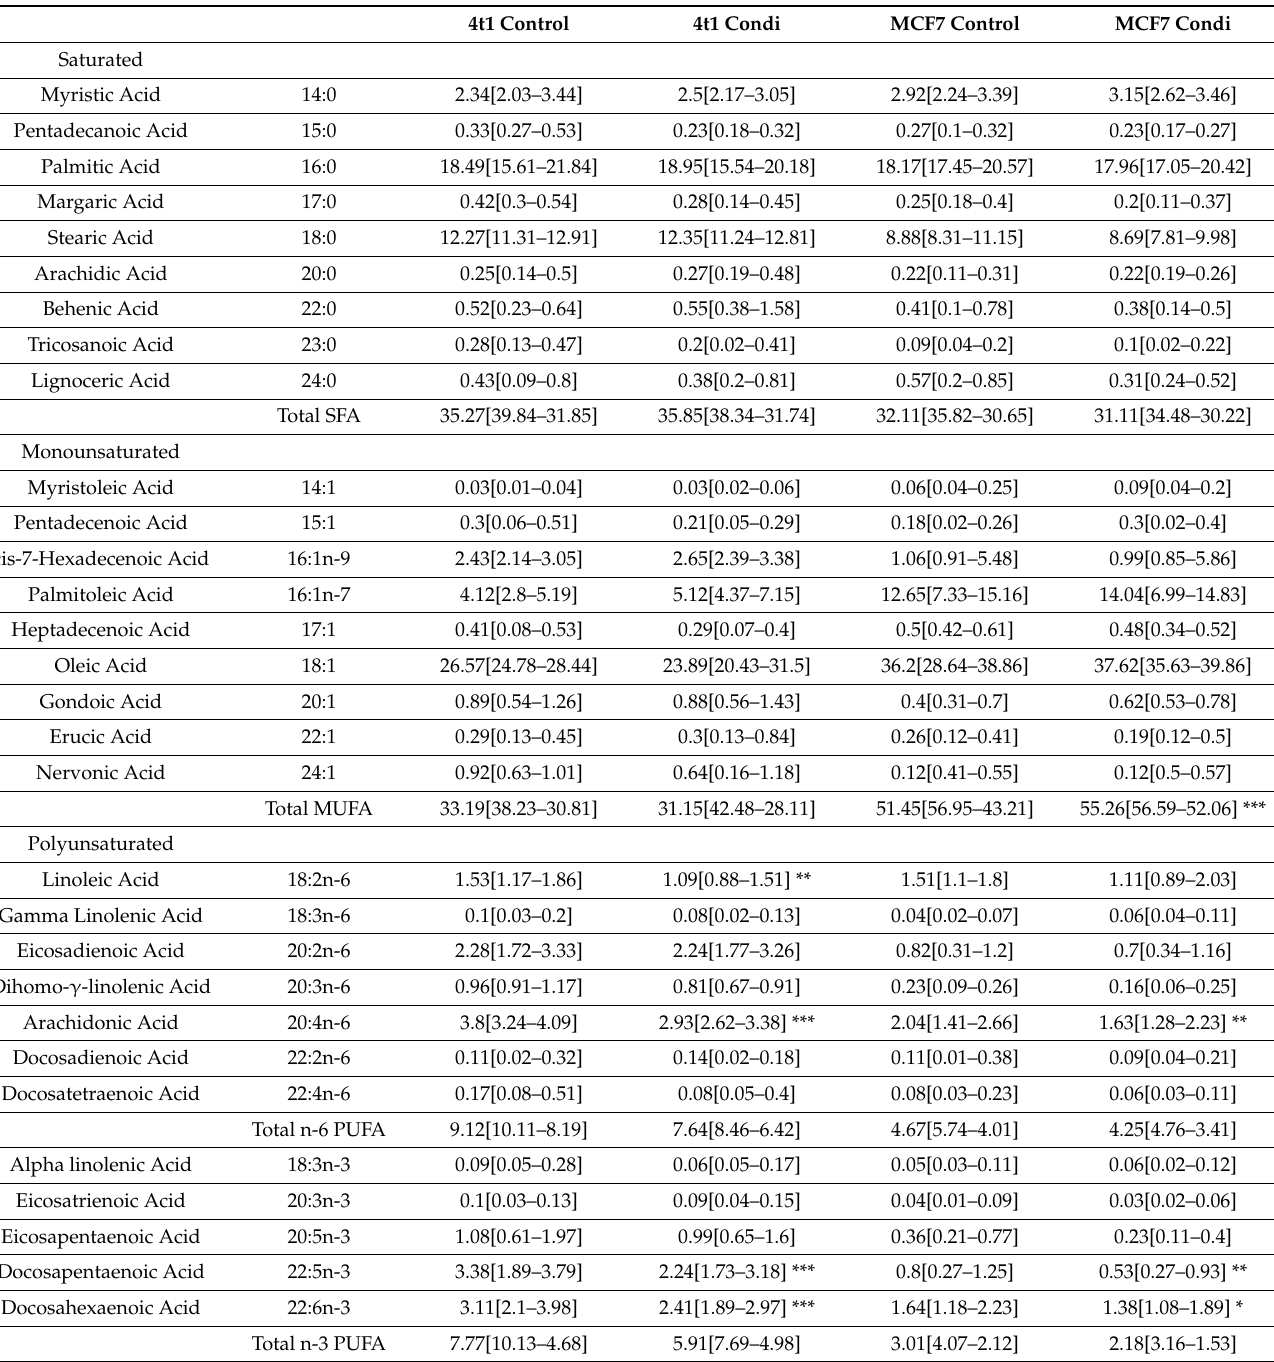
Table 1. Adipocyte-conditioned medium regulates fatty acid composition in breast cancer cells. Fatty acid ester composition in phospholipids from MCF7 and 4T1 cells treated with conditioned media from OP9 Dif and control media for 24 h. Data are expressed as the median percentage of total integrated peaks with range. Two-way ANOVA followed by Bonferroni’s multiple comparisons test, * p < 0.05; ** p < 0.01 and *** p < 0.001. SFA: saturated fatty acid, MUFA: monounsaturated fatty acid, PUFA: polyunsaturated fatty